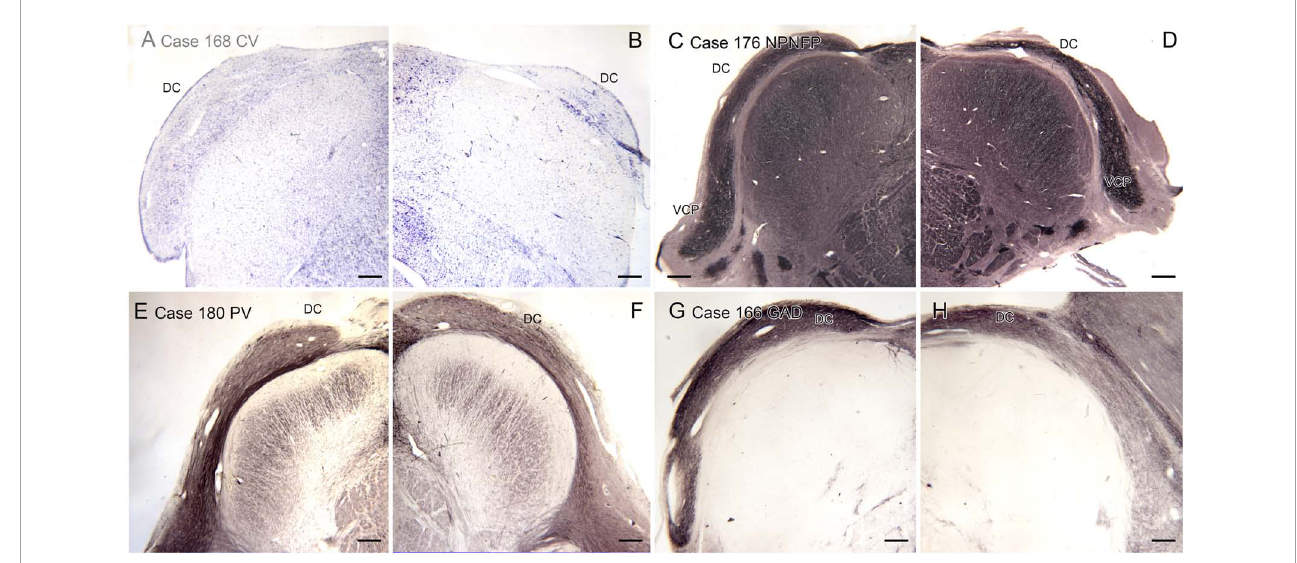
FIGURE8 Differences in the rostro-caudal level of the DC on left and right sides of a single section. (A,B) The DC in Case 168, CV-stained section. The DC on the right is smaller than on the left, consistent with a more caudal level. (C,D) The DC and VCP on the left and right sides of Case 176, section immunostained for NPNFP. The DC is smaller on the right. (E,F) Case 180, section immunostained for PV. The DC on the left is smaller. (G,H) The DC in Case 166, section immunostained for GAD 65 / 67 . The left side is caudal to the right. Scale bars = 500 µ